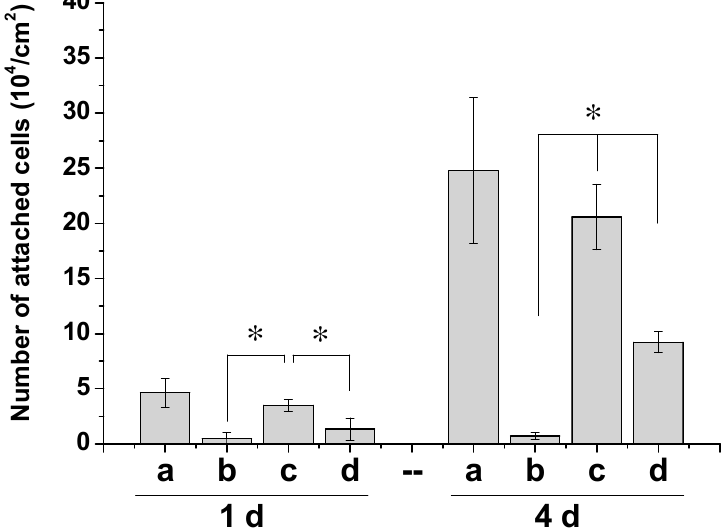
Figure 3. Cell counts of ADSCs on the different dressings after 1 and 4 d culture: tissue culture plate (TCP) ( a ), PVA ( b ), Az-Gel@PVA with and without UV irradiation ( c , d ). * p < 0.05, n = 4.